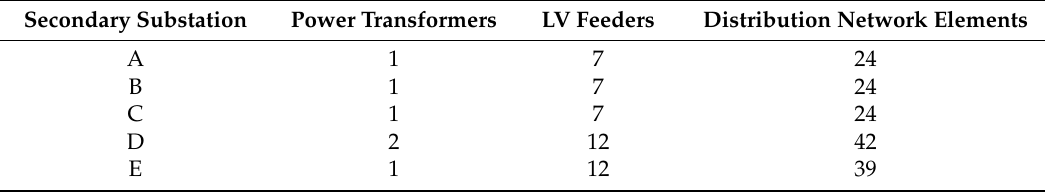
Table 2. Distribution network elements of the group considered in the case study.